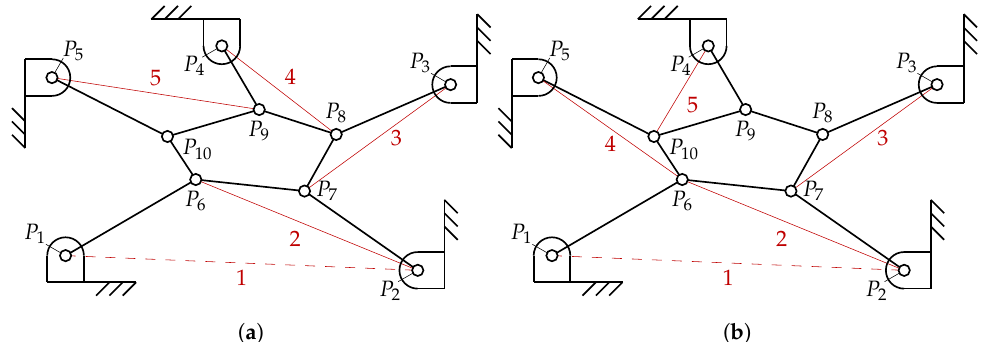
Figure 3. ( a ) a bilateration approach for solving the Direct Kinematic Problem (DKP) of a 5-RR structure; ( b ) a second possible approach. Each bilateration step is denoted in